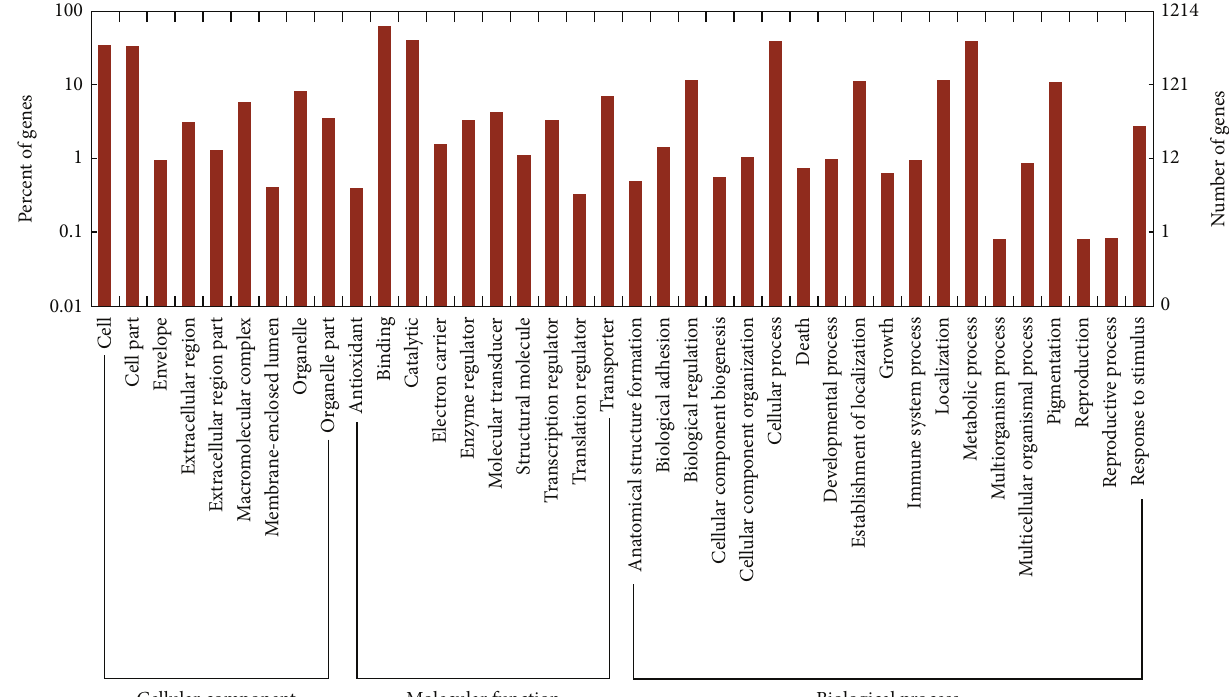
Figure 2: GO annotation results of the differently expressed transcripts between the high and low carcass fat content rainbow trout.